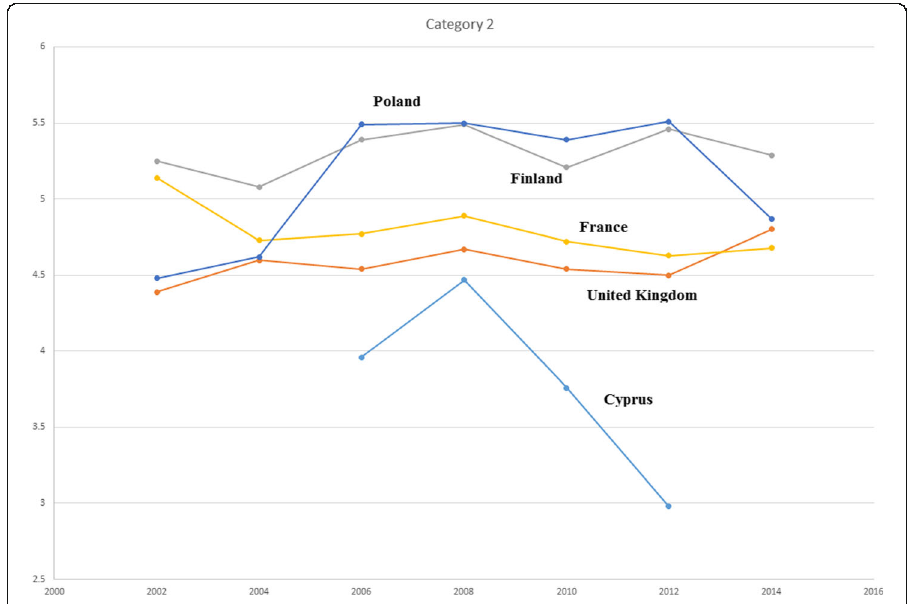
Fig. 3 Immigration good or bad for the economy (1 – 10) (Source: ESS round 1 – 7 (2002 –